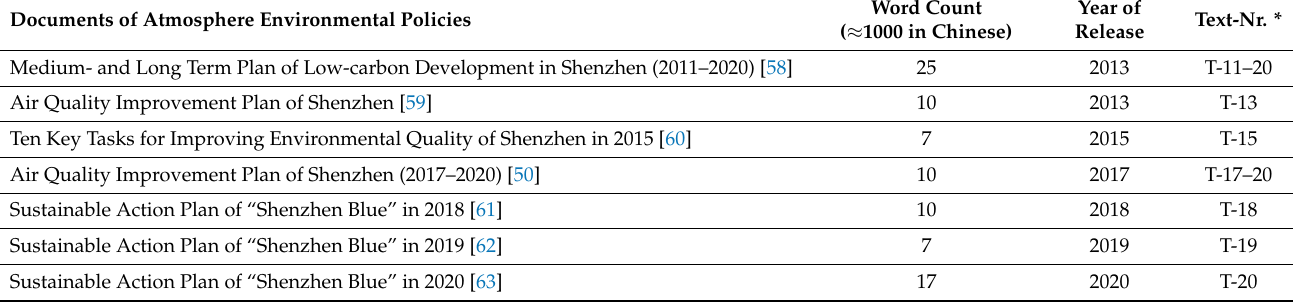
Table 7. Policy documents issued in Shenzhen for environmental improvement.